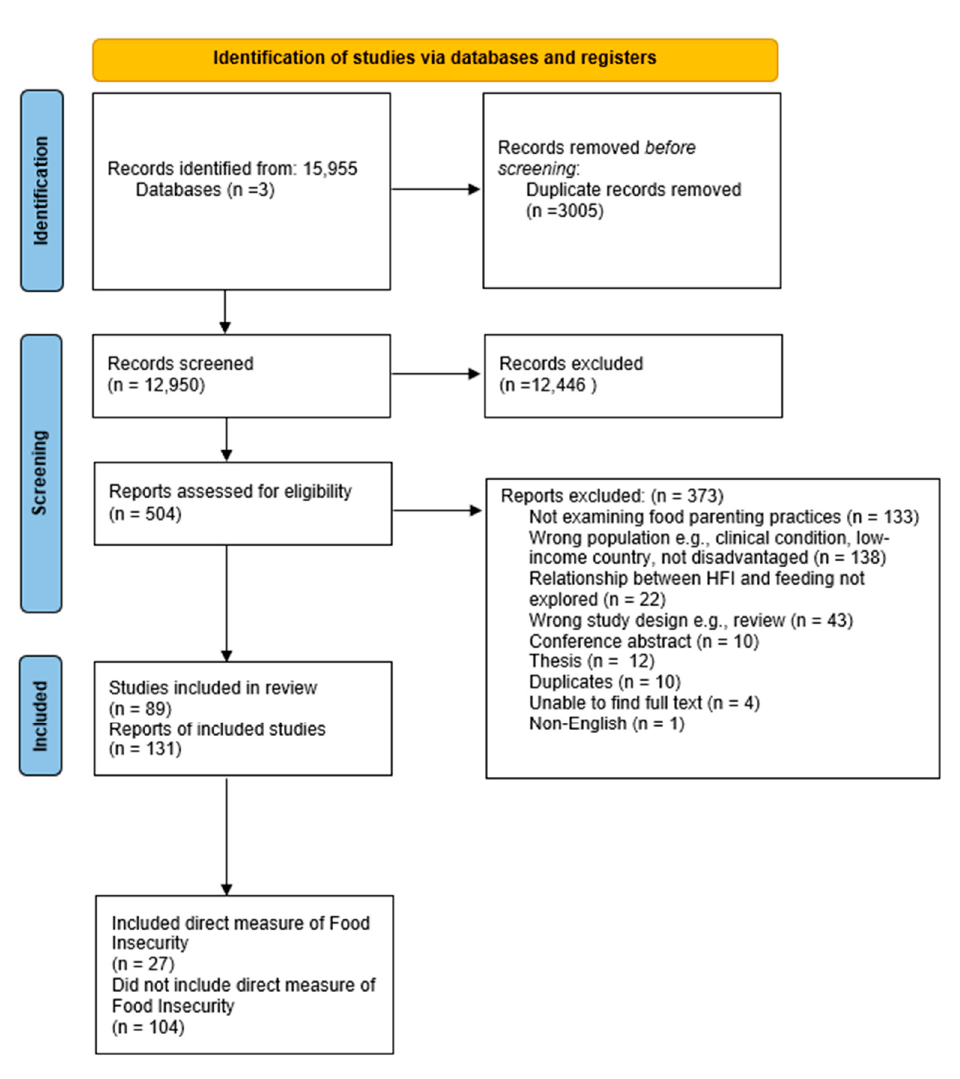
Figure 2. PRISMA diagram Figure 1. PRISMA diagram [38].